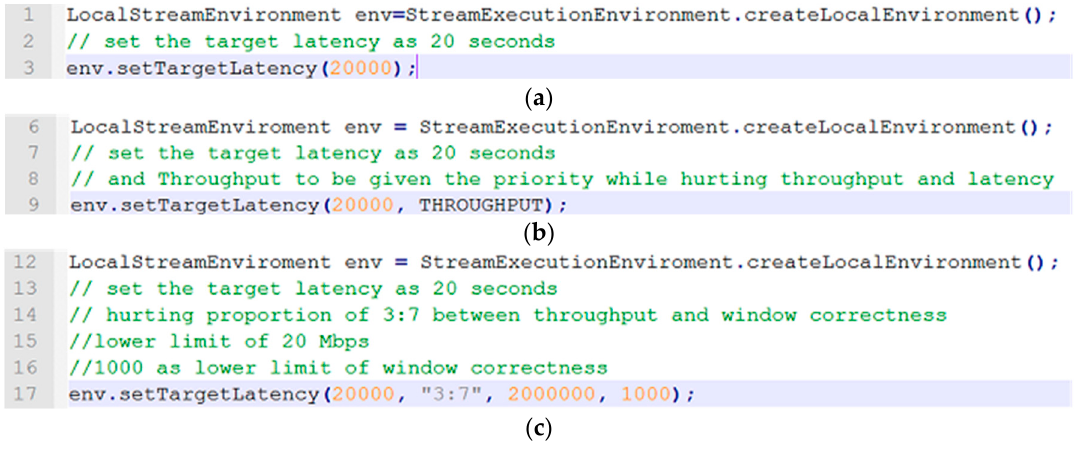
Figure 11. ( a ) Fully automated mode example: Setting latency to 20 s according to SLA agreement. ( b ) Semi-automated mode example: Setting latency to 20 s and prioritizing throughput over latency according to SLA agreement. ( c ) Manual mode example: Setting latency to 20 s, ratio of 3:7 between throughput and window correctness, threshold of throughput to 20 MB, and threshold of window correctness to 1000 according to the SLA agreement.